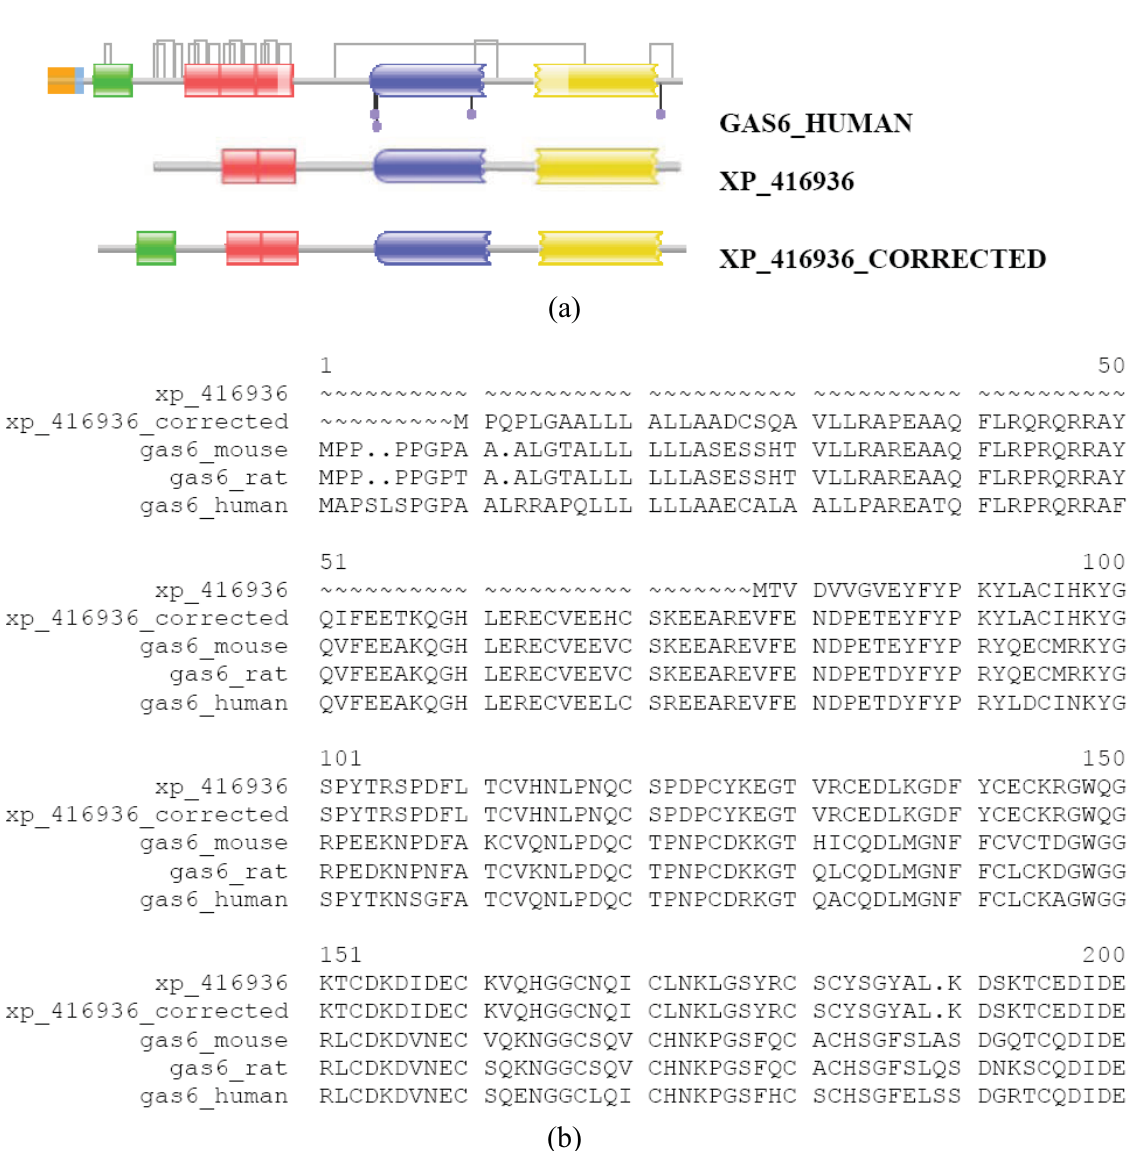
Figure S8. Correction of the sequence of the XP_416936 protein of Gallus gallus with the FixPred protocol. The DA of the GNOMON predicted protein XP_416936 was found to differ from those of GAS6_MOUSE, GAS6_RAT, GAS6_HUMAN: whereas the latter contain a signal peptide, a Gla, three EGF_CA, a Laminin_G_1 and a Laminin_G_2 domain, XP_416936 lacks the N-terminal signal peptide and Gla domain. The sequence XP_416936_CORRECTED was predicted by the use of ESTs CD217792, BM439645 and BU115578. (a) Comparison of the DAs of XP_416936, XP_416936_CORRECTED with those of GAS6_MOUSE, GAS6_RAT and GAS6_HUMAN. Note that some of the four EGF_CA domains of GAS6 proteins are detected with E-values >0.0001 and are not represented in the DA images generated by Pfam. (b) Alignment of the sequences of XP_416936, XP_416936_CORRECTED with those of GAS6_MOUSE, GAS6_RAT and